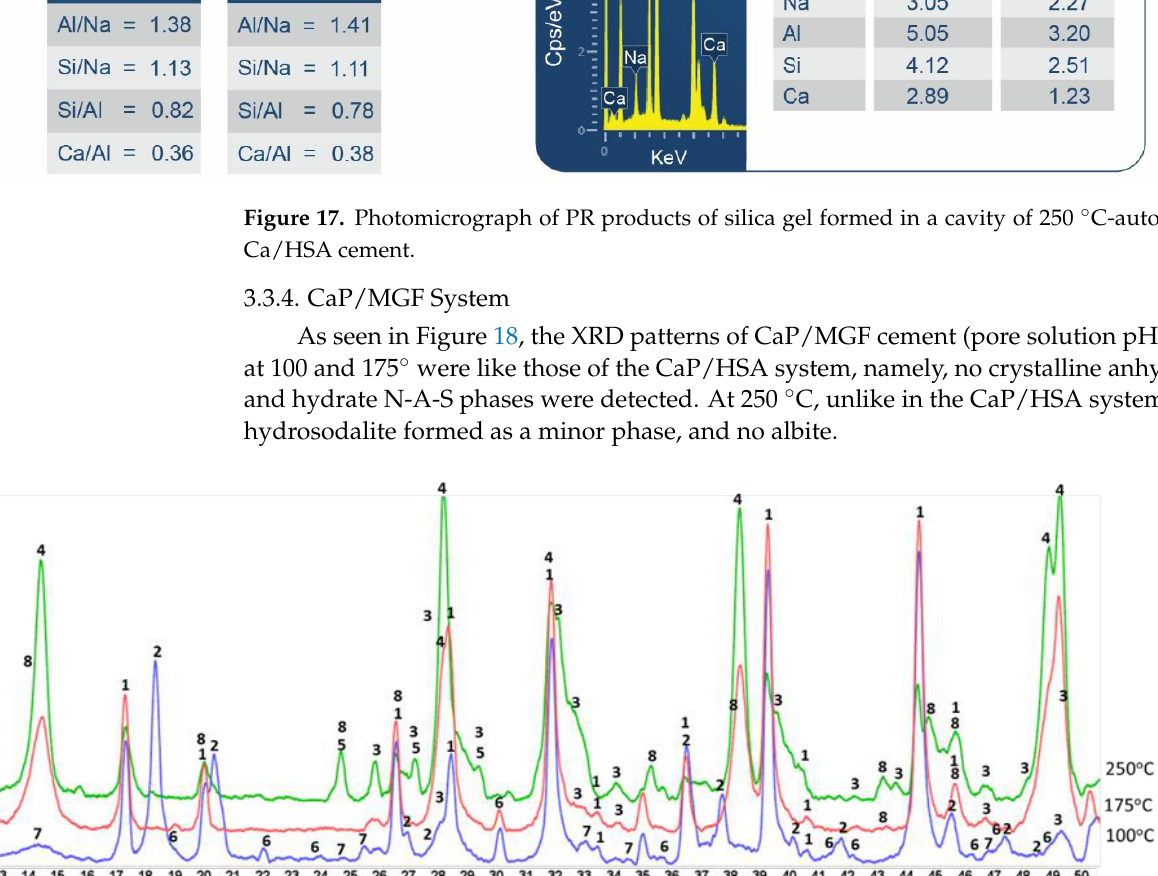
Figure 17. Photomicrograph of PR products of silica gel formed in a cavity of 250 °C-autoclaved Ca/HSA cement.